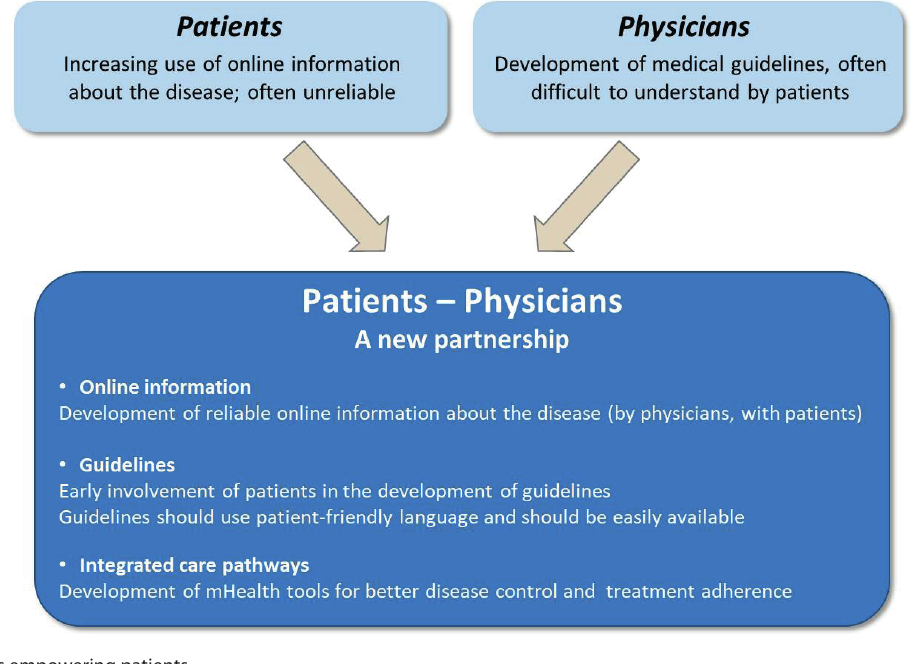
Figure 3. Guidelines empowering